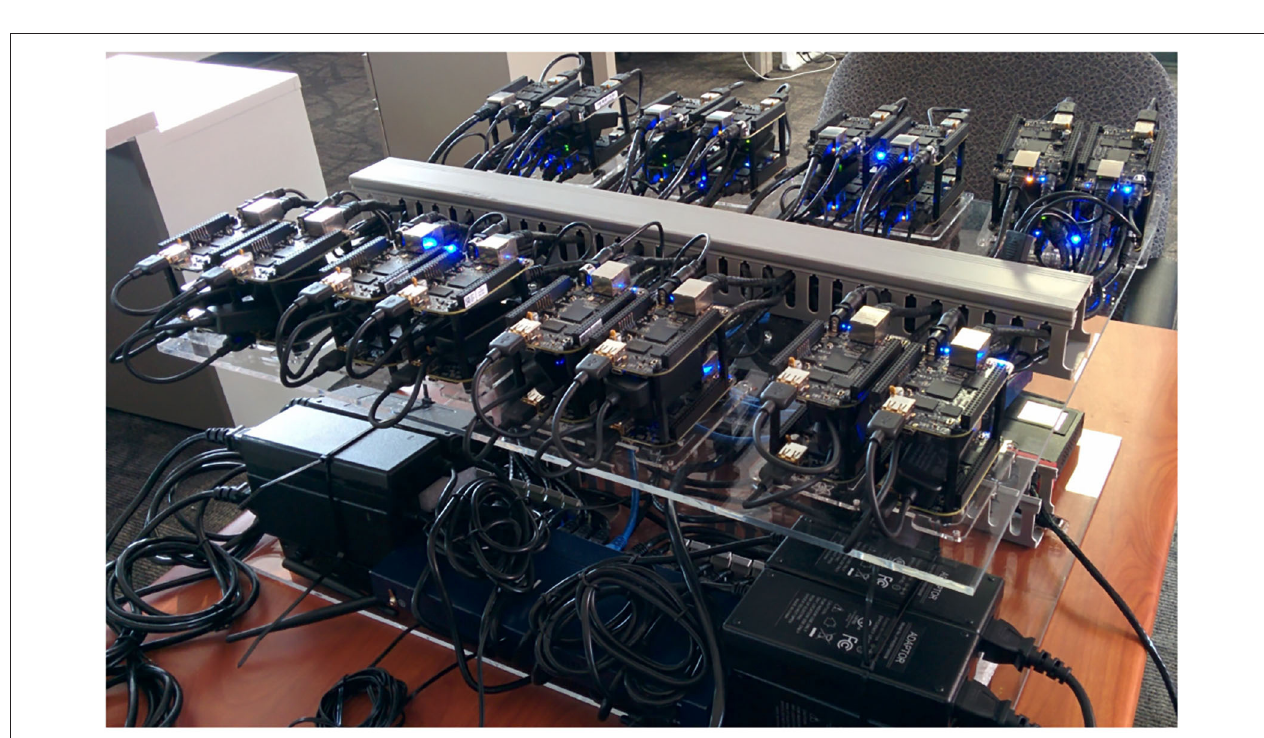
FIGURE 7 | Energy offered in each time interval by the first prosumer of the first feeder when using a battery (shown by the blue line).